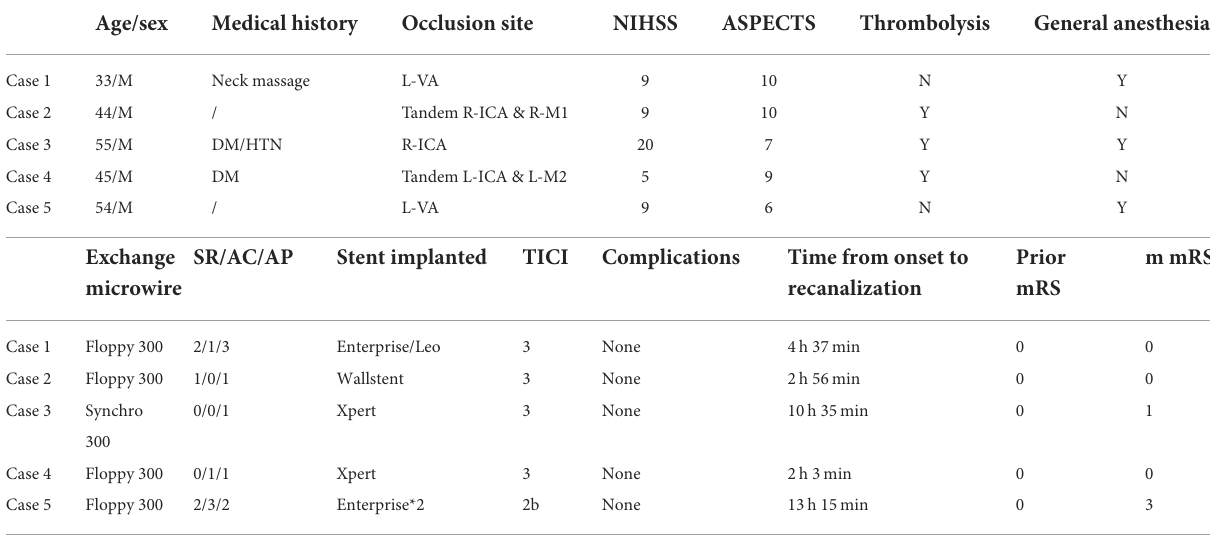
TABLE 1 Characteristics of enrolled patients.